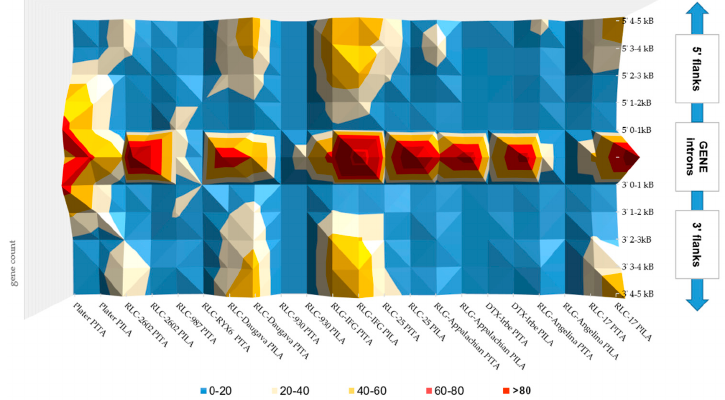
Figure 1. Comparison of TE distribution in gene non-coding regions of high-quality genes of the P. lambertiana genome v.1.01 (PILA) and filtered annotated gene set of P. taeda v.2.0 (PITA). Genes 2017 , 8 , x FOR PEER REVIEW